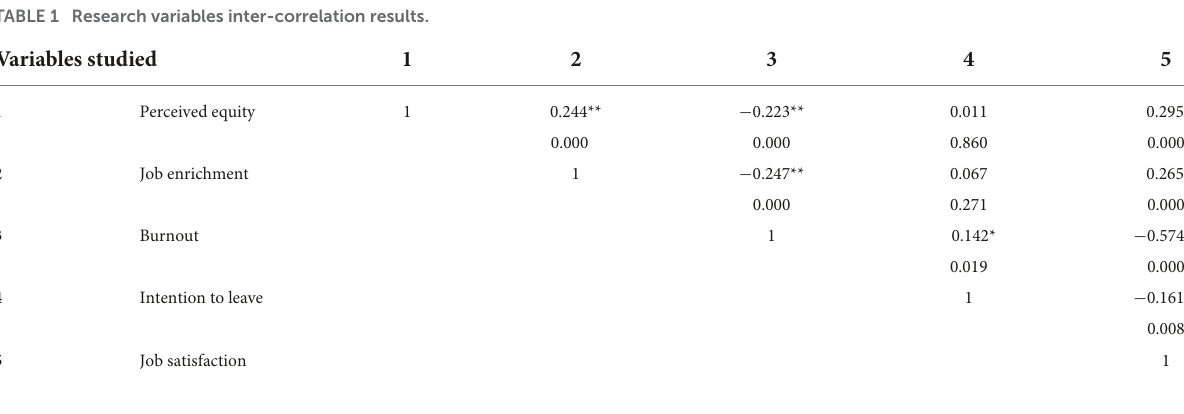
TABLE 1 Research variables inter-correlation